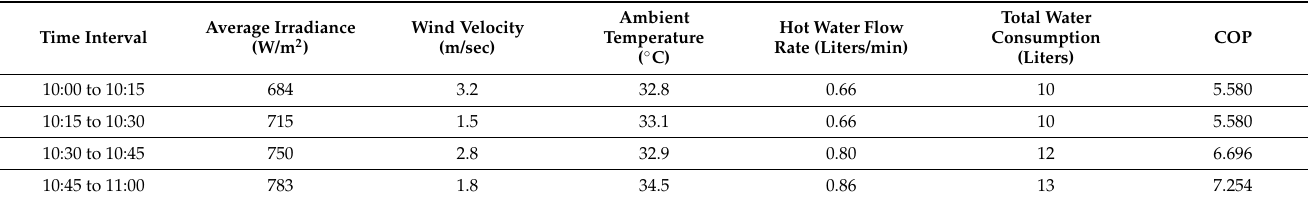
Table 4. Total water consumption—45 L (Electricity consumption—0.3 kWh).